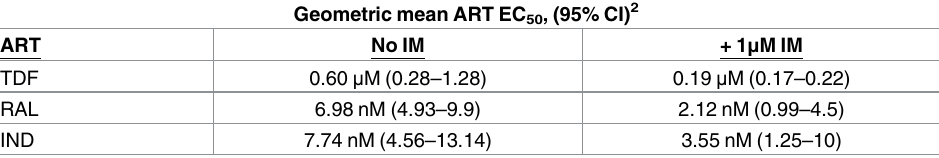
Table 2. IM enhances inhibition of HIV NL4-3 by tenofovir (TDF), raltegravir(RAL) and indinavir (IND) in PBMCs 1